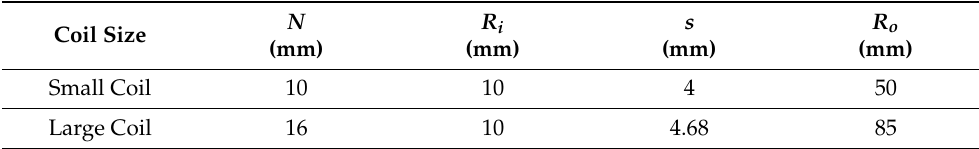
Table 4. Geometrical parameters of experimental coils.